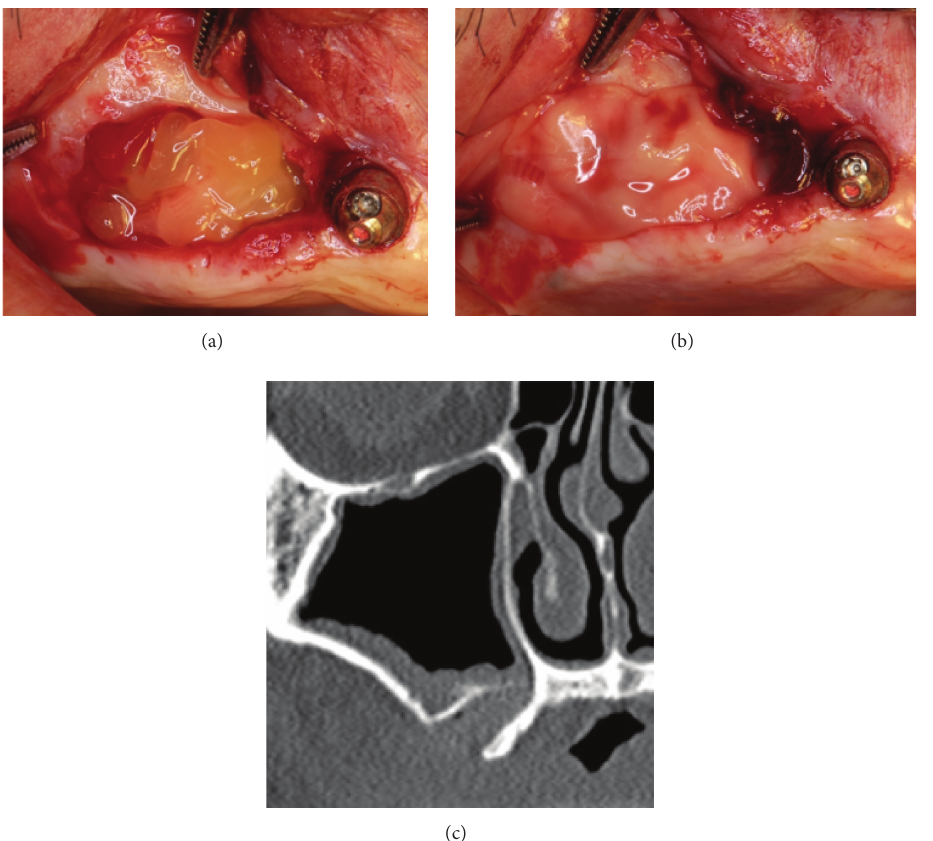
Figure 6: Sinus augmentation using the lateral window technique. (a) PRF clots were filled inside the sinus cavity and (b) the PRF membrane was used to cover the osteotomy window. (c) A CT image taken immediately after sinus augmentation using PRF only.